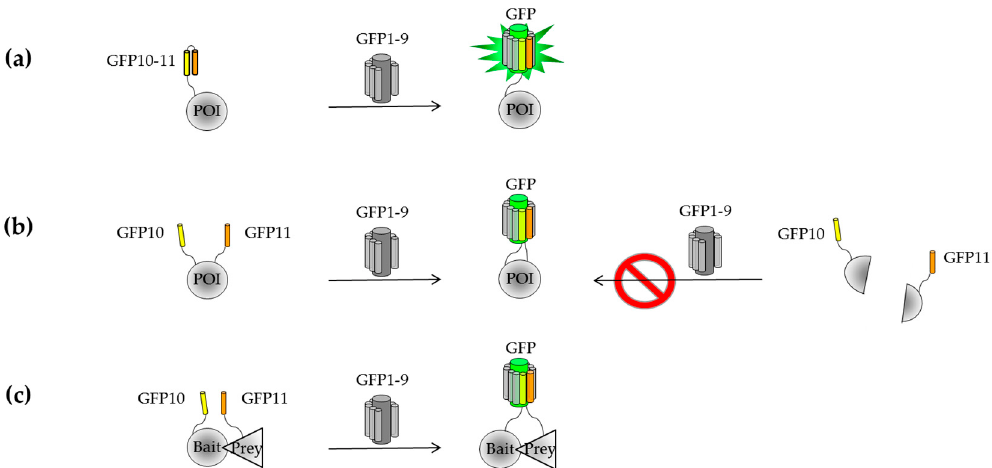
Figure 3. Stepwise engineering of a tripartite split-GFP protein–protein interactions (PPI) detector. ( a ) Bipartite self-system based on GFP10–11/GFP1–9 association. ( b ) Bipartite self-association system based on a sandwich model GFP10-POI-GFP11 where strands β 10 and β 11 are positioned at the N- and C-terminus of the POI, respectively. The proximity of strands β 10 and β 11 allows the association with GFP1–9. A truncated POI leads to GFP10 and GFP11 fusions that are unable to associate with GFP1–9 (right image). ( c ) Interactions between bait and prey proteins bring GFP10 and GFP11 closer in space for complementation with GFP1–9.